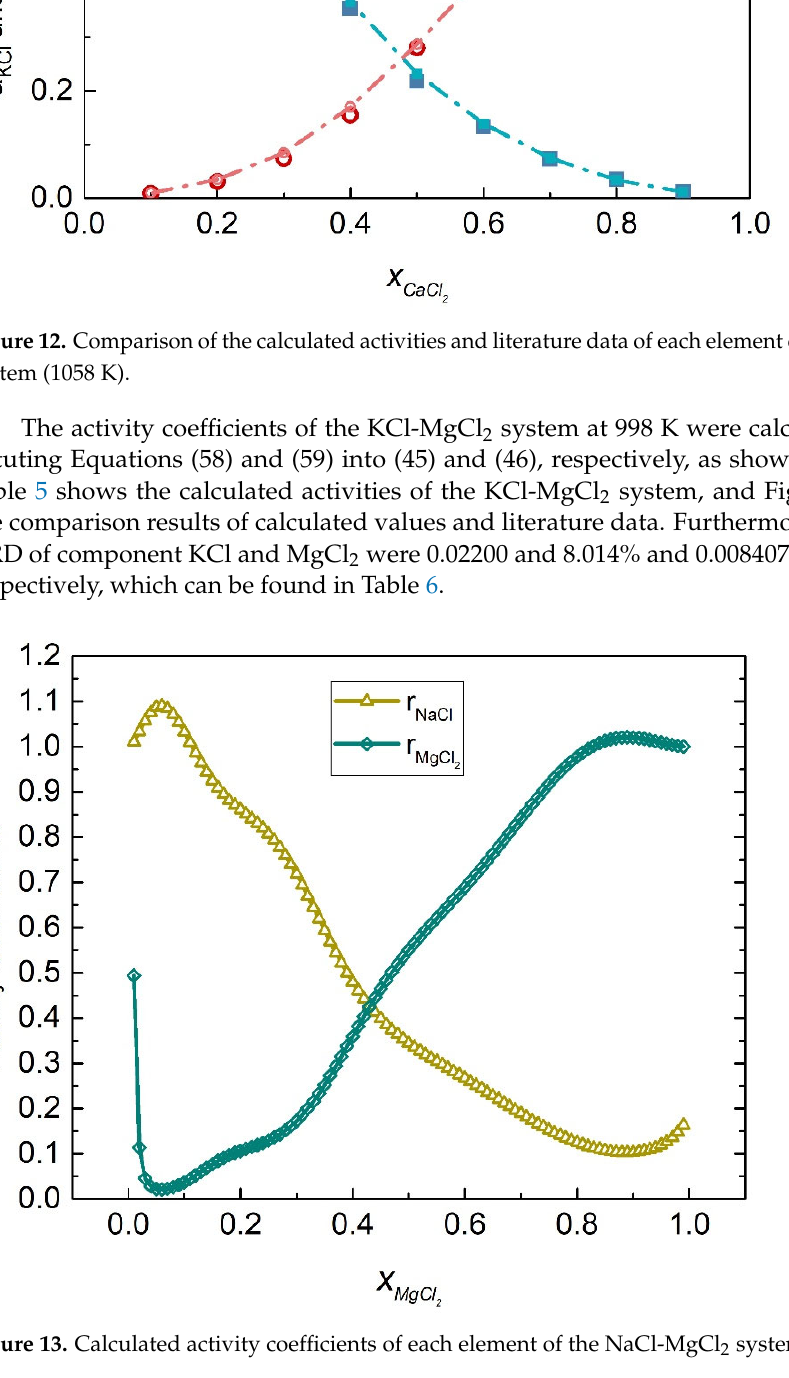
Figure 14. Comparison of the calculated activities and literature data of each element of the NaCl ‐ MgCl 2 system (1098 K).